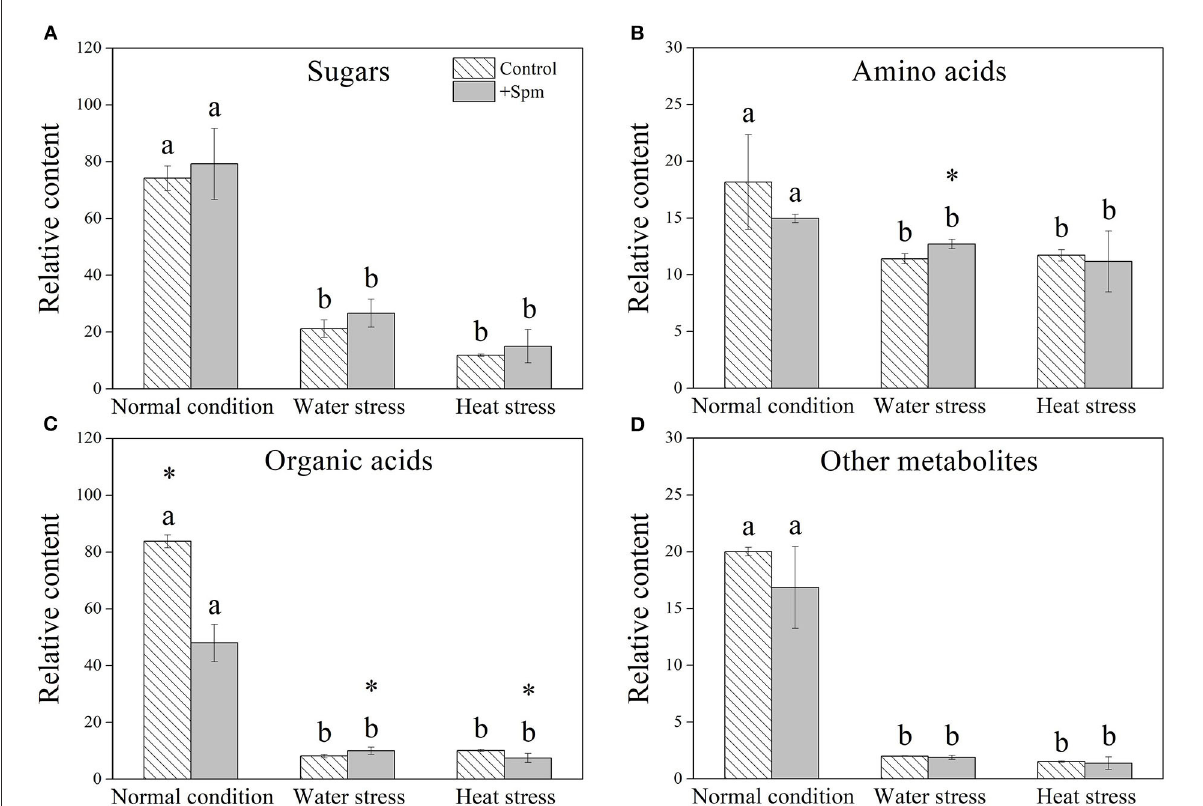
FIGURE6 Changes in the relative content of (A) sugars, (B) amino acids, (C) organic acids, and (D) other metabolites in response to Spm application under different conditions. Vertical bars indicate ± SE of mean ( n = 4). Different letters above striated or gray columns indicate significant differences for a particular treatment (Control or + Spm) for comparison across the normal condition, water stress, and heat stress; the asterisk “*” indicates significant differences between the control and the + Spm treatments under one particular condition (normal condition, water stress, or heat stress) based on LSD ( P <